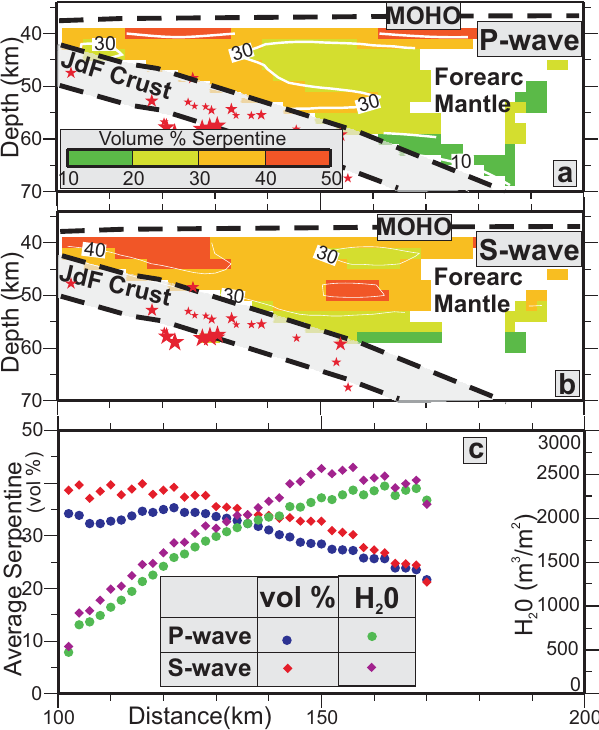
Fig. 6. Plot of volume percent serpentinization in the forearc mantle computed from (a) P-wave velocity and (b) S-wave velocity for the region enclosed by the red box in Fig. 4c (100–200km distance on profile AB shown in Fig. 1). (c) Plot of average volume % serpen- tine and total water content in a unit column of the forearc